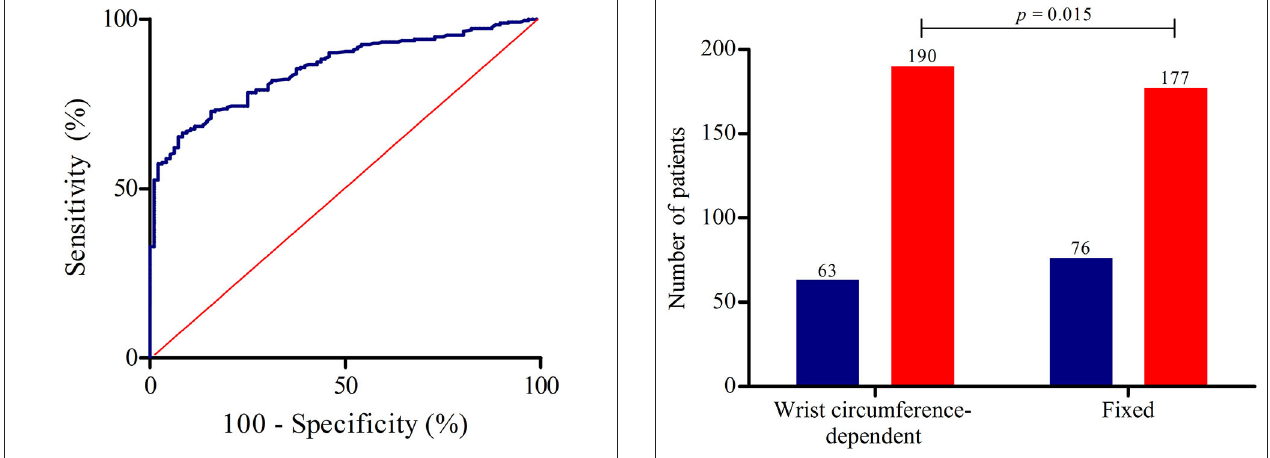
FIGURE 2 | ROC curve of the calculated z -scores (healthy controls and clinically defined carpal tunnel syndrome patients). AUC = 0.854, 95% confidence interval: 0.815–0.893.